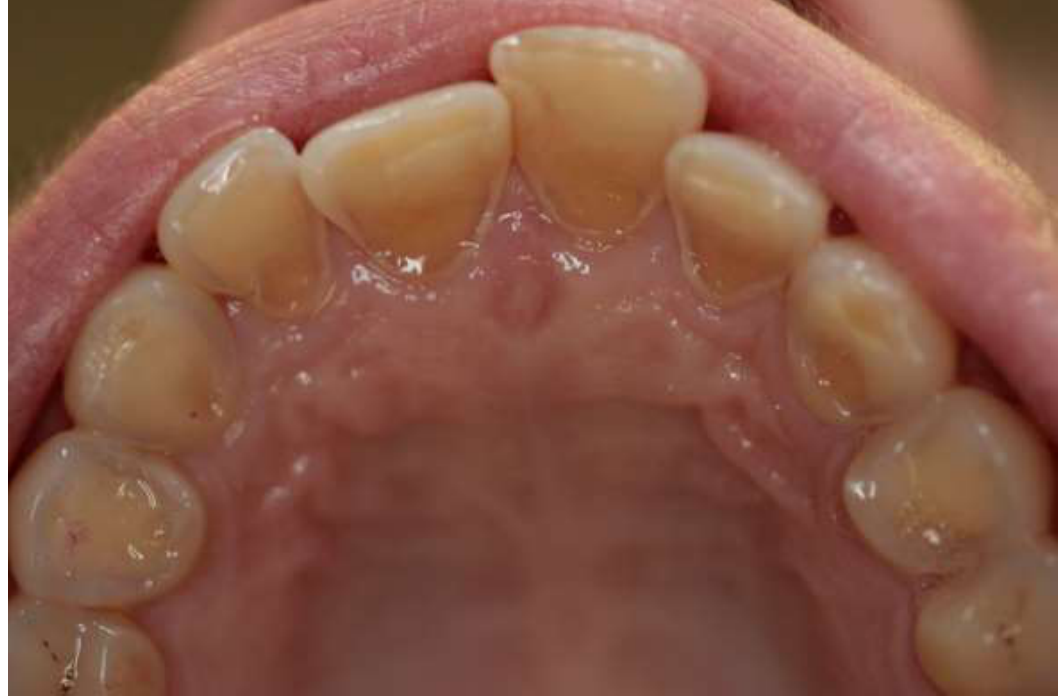
Figure 2. Erosive lesions on palatal surfaces of incisors and canines (personal collection).